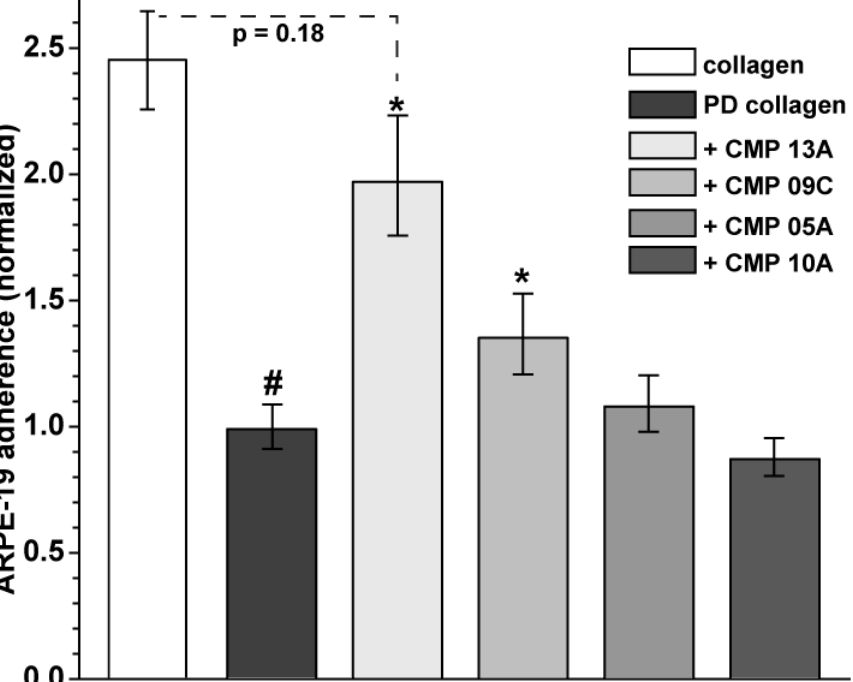
Figure 2. Quantification of ARPE-19 cell adherence. Adherence of ARPE-19 cells plated on collagen partially digested with MMP-1 as described and treated with 100 µ M of CMP as indicated. MMP-1 digestion diminished adherence by 58% compared to intact collagen (#, p < 0.001). When normalized to untreated partially digested (PD) collagen, both CMP 13A and CMP 09C increased adherence significantly (*, p ≤ 0.04), and adherence with CMP 13A did not differ from intact collagen ( p = 0.18). Data = mean ± SEM ( n ≥ 61 samples for each condition).